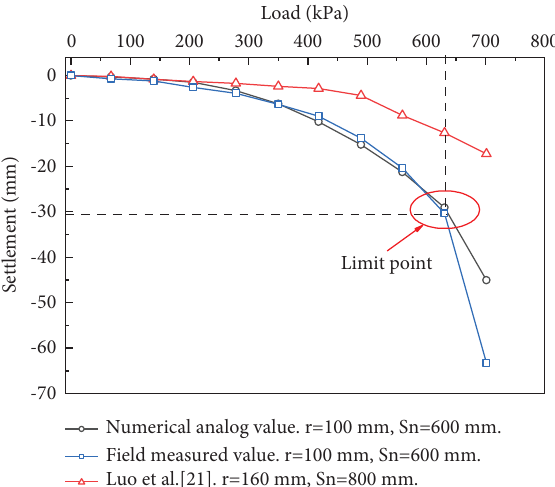
Numerical analog value. r=100 mm, Sn=600 mm. Figure 17: Comparison of measurement results and those of numerical